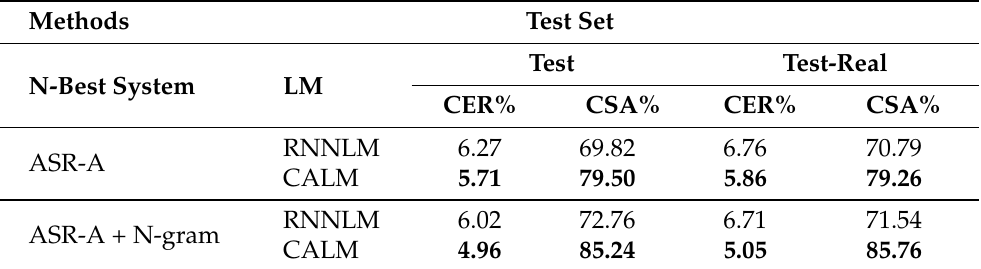
Table 4. The rescoring results with LM (English word).